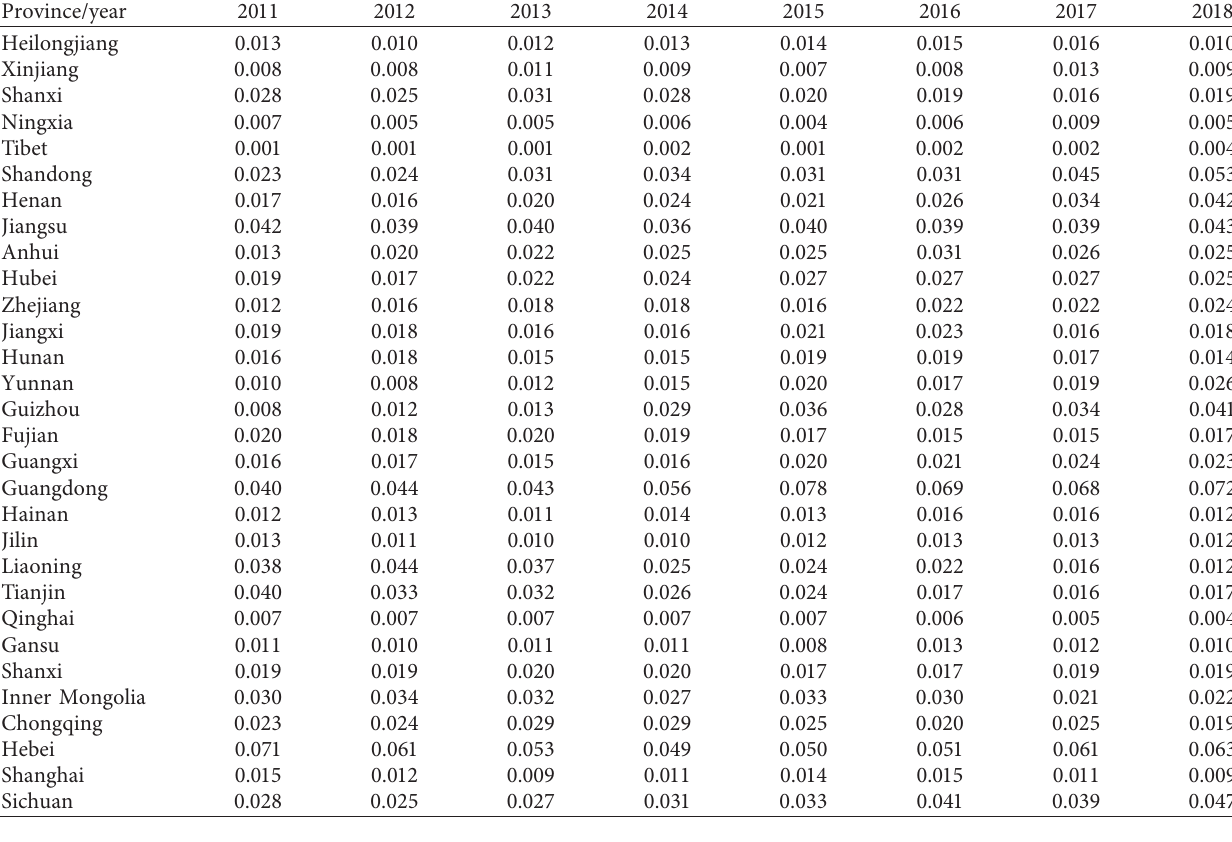
Table 2: Externality statistics of Beijing’s construction industry.